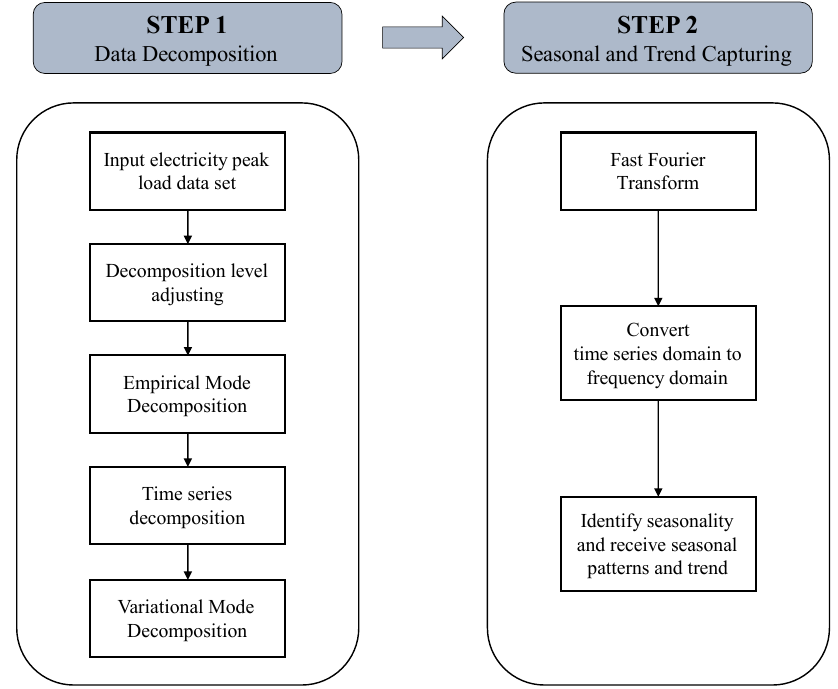
Figure 6. The data decomposition and seasonality capturing flowchart.